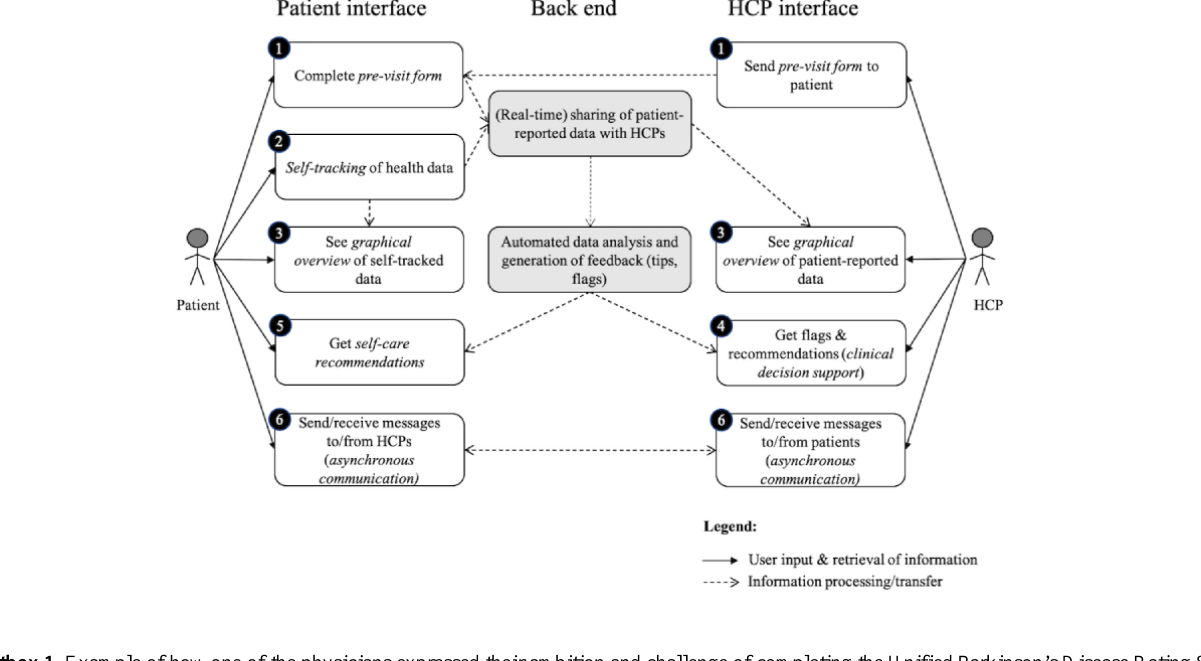
Textbox 1. Example of how one of the physicians expressed their ambition and challenge of completing the Unified Parkinson’s Disease Rating Scale (UPDRS) during